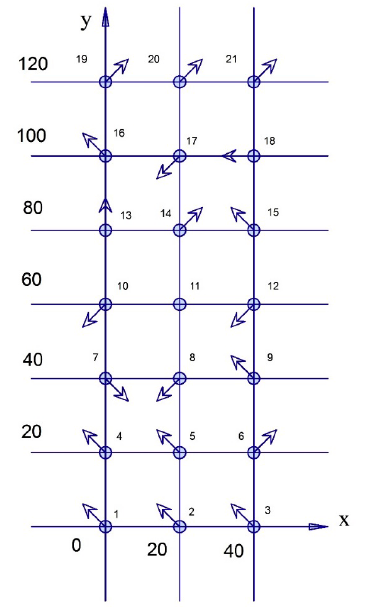
Figure 2. The scheme of placement of points on the equipment and directions of their deviation after